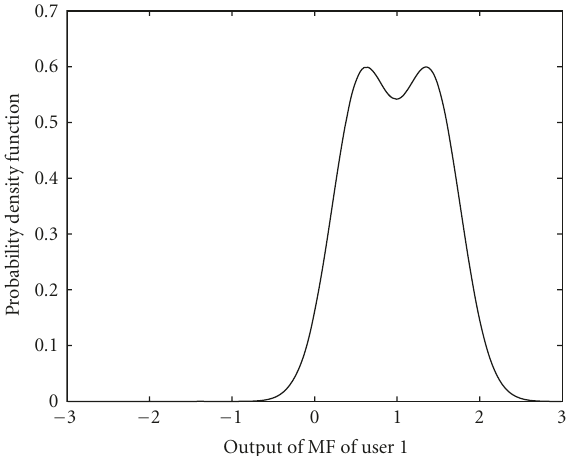
Figure 1: Conditional pdf such as b 1 = +1 of the output of matched filter for user k = 1 and for an SNR = 6 dB .